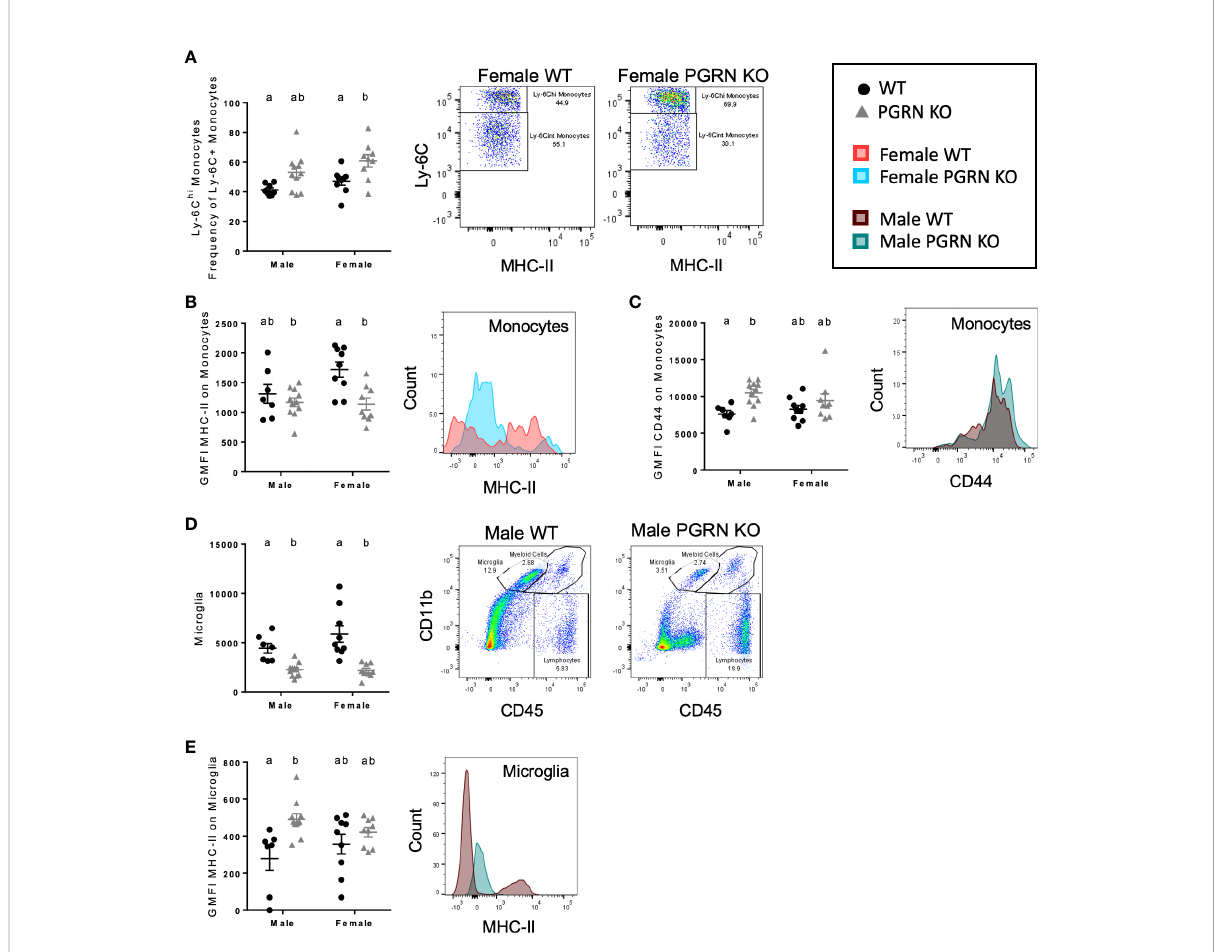
FIGURE 2 PGRN de fi cient mice exhibit altered monocytic and microglial immunophenotypes in the peripheral blood and brain. (A) Ly-6C hi frequency of Ly-6C + monocytes in peripheral blood, geometric mean fl uorescence intensity (GMFI) of (B) MHC-II and (C) CD44 on monocytes in the brain, (D) microglia counts, and (E) GMFI of MHC-II on microglia from aged WT and PGRN KO mice (n=8-10) determined by fl ow cytometry; two-way ANOVA, genotype effect p < 0.01 for all, Tukey ’ s post hoc . Histograms show distribution of fl uorescence intensity per cell. Letter(s) centered above groups re fl ect results of post hoc tests. Groups that do not share any letters are signi fi cantly different from one